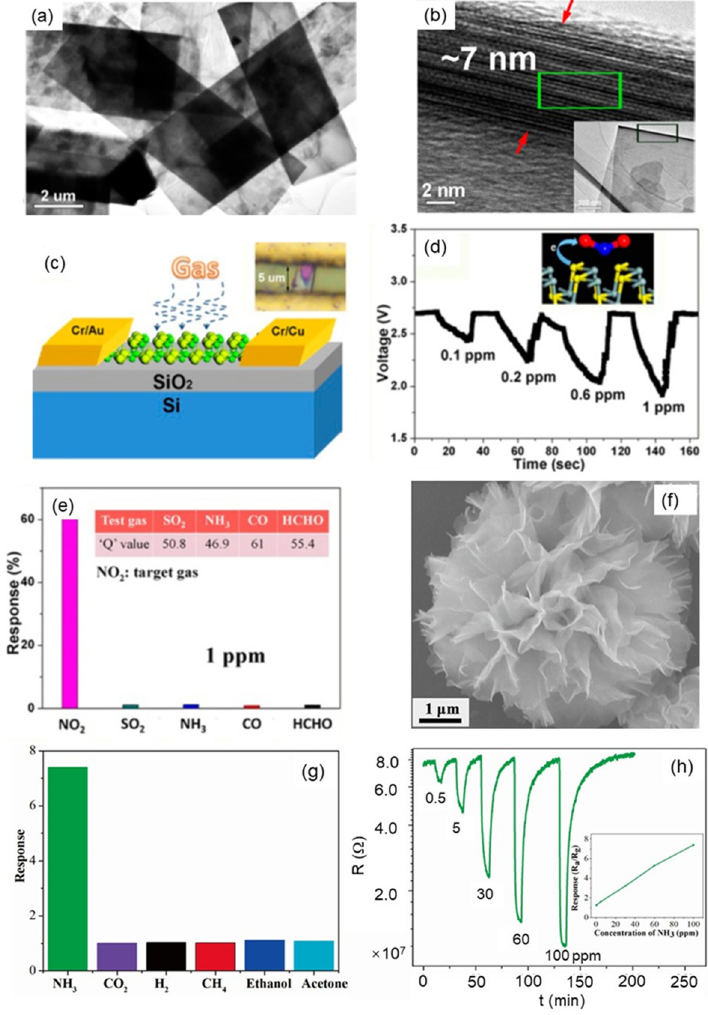
Figure 7. TEM ( a ) and HRTEM ( b ) images of 2D thin SnS crystals. Inset in ( b ) is the corresponding low-magnification TEM image. ( c ) Schematic structure of SnS thin-crystal-based gas-sensor device. The inset shows the optical image of the device. ( d ) Real-time voltage response after exposure of the device to NO 2 gas with increased concentration. The inset schematically illustrates the electron transfer process from SnS to NO 2 . ( e ) Selectivity of the sensor to a series of gases of 1 ppm. Inset shows the Q values of the SnS thin crystal sensor for NO 2 as a target gas. Reprinted with permission from Ref. [79]. Copyright 2016 ACS. ( f ) Representative FESEM image of the flower-like SnS 2 synthesized by a facile solvothermal technique. ( g ) Sensor responses of the SnS 2 based sensor upon exposure to six kinds of gases at 200 ◦ C. ( h ) Typical response-recovery characteristic of the SnS 2 based sensor to different concentrations of NH 3 gas at 200 ◦ C (Inset shows the corresponding response curve). Reprinted with permission from Ref. [80]. Copyright 2018